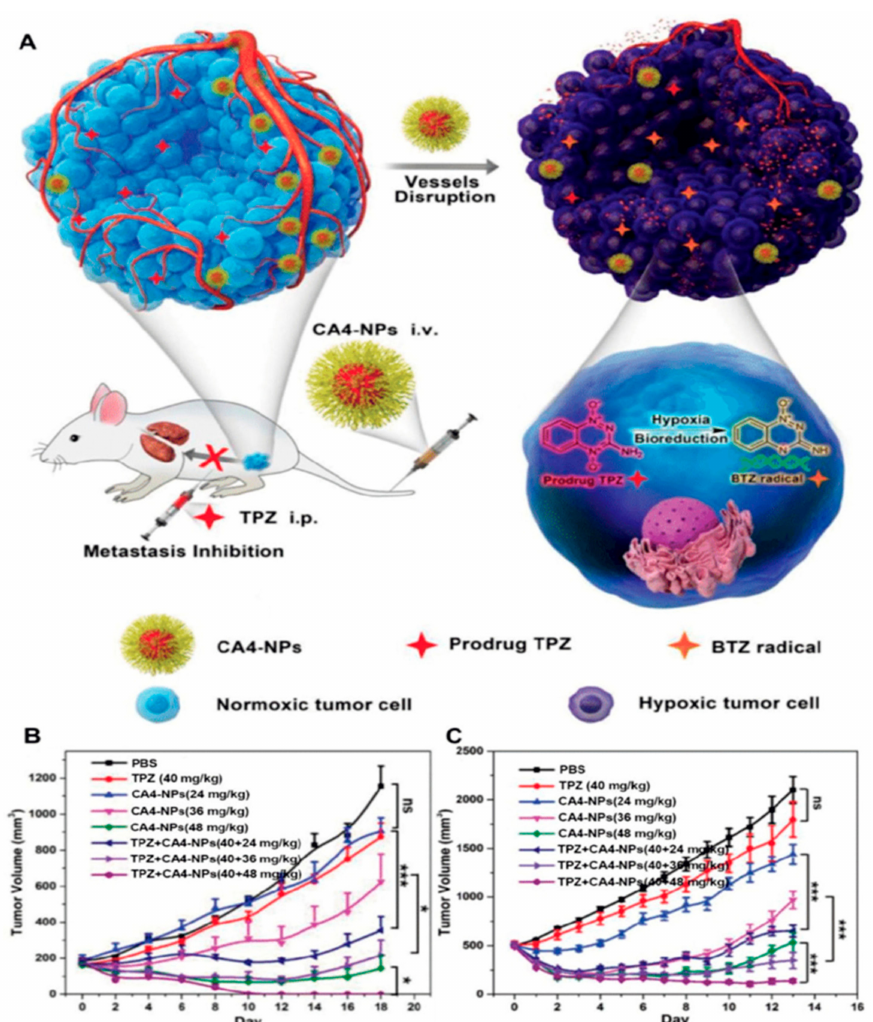
Figure 5. Schematic illustration of hypoxia-inducing vascular disrupting agents (VDA) nanodrug combined with hypoxia-activated prodrug for cancer therapy ( A ). Tumor volume changes of BALB / c mice bearing 4T1 tumors with both moderate sizes ( ≈ 180 mm 3 ) ( n = 6) ( B ) and large sizes ( ≈ 500 mm 3 ) ( n = 6). ( C ). All data points are presented as mean ± standard deviation (s.d.) (* p < 0.05, ** p < 0.01, *** p < 0.001). Reproduced with permission from [109]. Copyright, 2019,